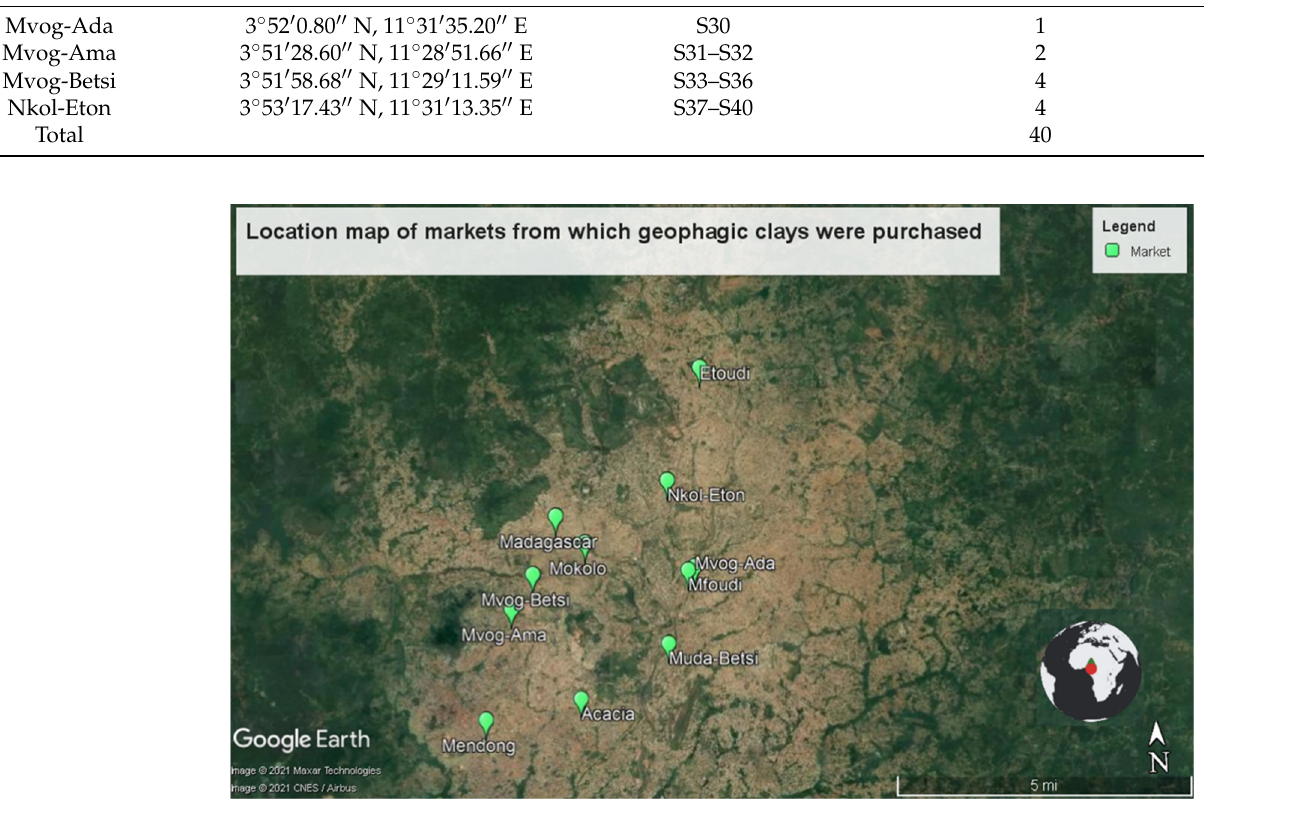
Figure 1. Location map of markets from which geophagic clays were purchased. Table 1. Number of geophagic clay samples per market.